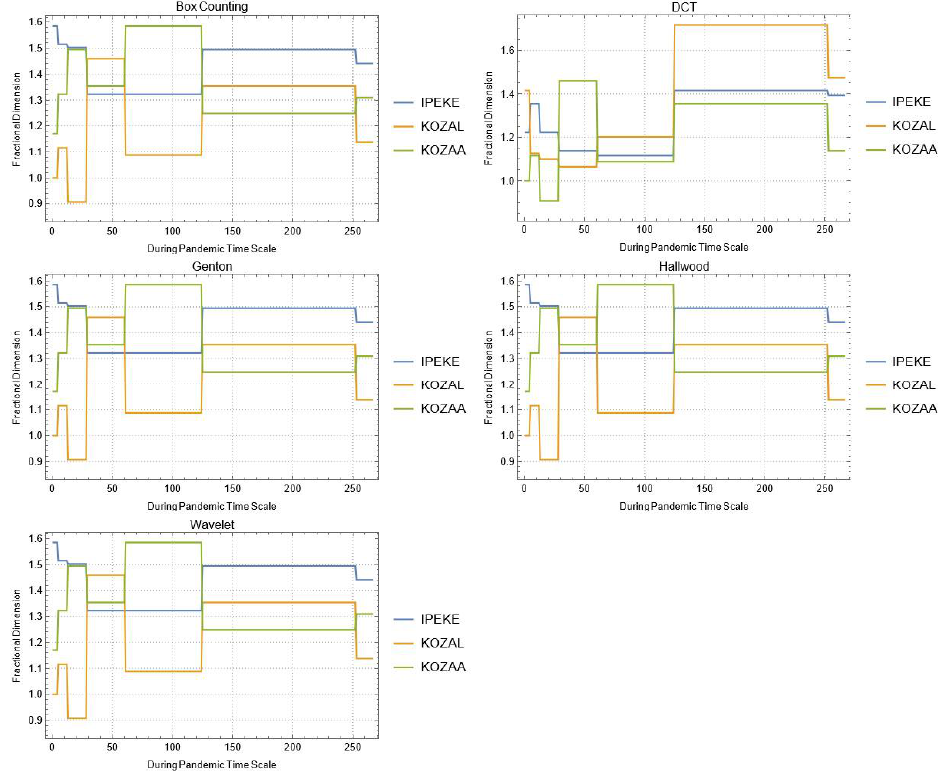
Figure A8. Daily changes of fractal dimensions during the pandemic (stone–soil-based manufacturing).